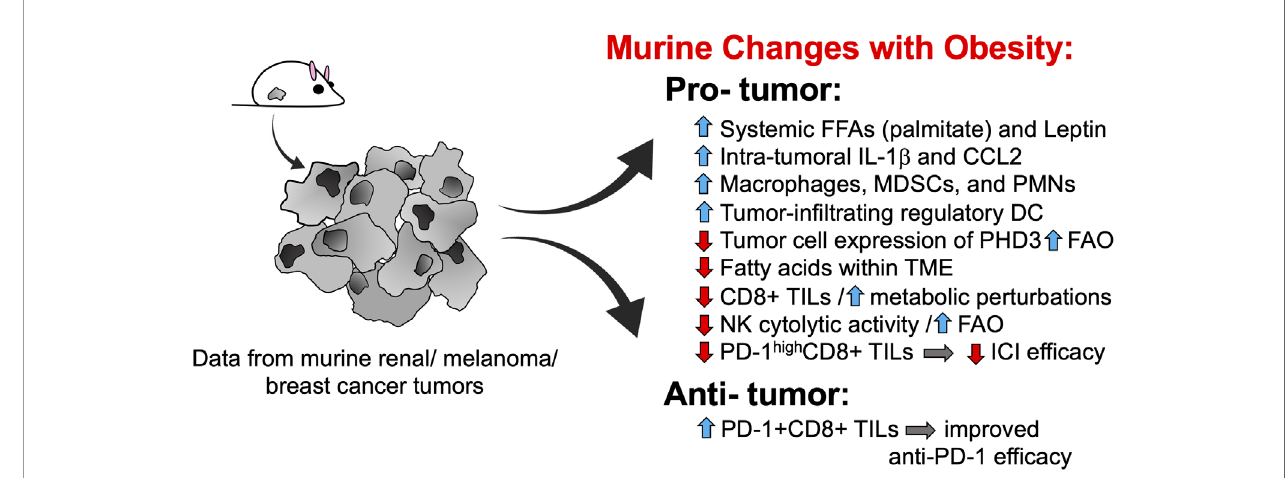
FIGURE 1 | Murine models reveal multiple pro-tumorigenic changes to anti-tumor immunity with host obesity. Pre-clinical tumor modeling provides evidence that host obesity is associated with a net increase in pro-tumorigenic changes to immune responses, although obesity-associated alterations that favor tumor clearance and/or enhanced ICI ef fi cacy have been described. DCs, dendritic cells; FAO, fatty acid oxidation; FFAs, free fatty acids; ICI, immune checkpoint inhibitor; IL-1, interleukin-1; MDSCs, myeloid-derived suppressor cells; NK, natural killer; PD-1, programmed cell death-1; PHD3, prolylhydroxylase-3; PMNs,